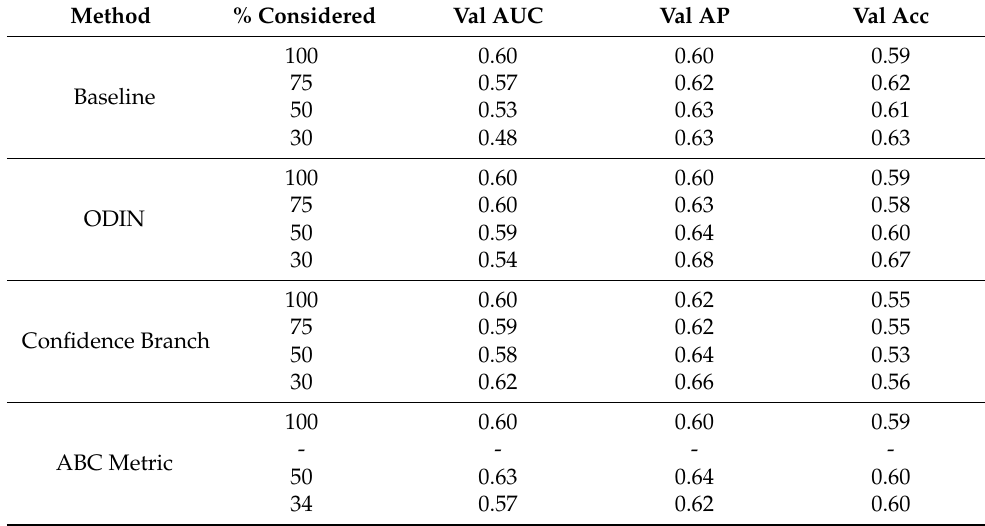
Table A7. Results of confidence metrics on the validation set. FLAIR-T1wCE-T1w-T2w, early fusion.